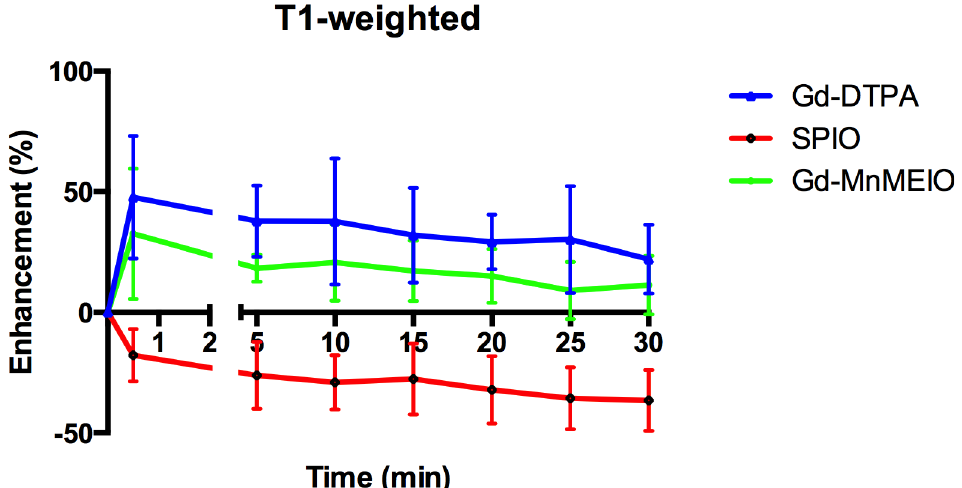
Fig 6. Time course curves of liver parenchyma enhancement on T1-weighted images by using Gd-DTPA (n = 8), SPIO (n = 8), and Gd-MnMEIO (n = 8). The error bars indicate standard deviation. Contrast enhancement with Gd-DTPA and Gd-MnMEIO is significantly better than with SPIO at every post-enhancement time point (p < 0.001), while no significant difference can be observed between Gd-DTPA and Gd-MnMEIO (p > 0.05).